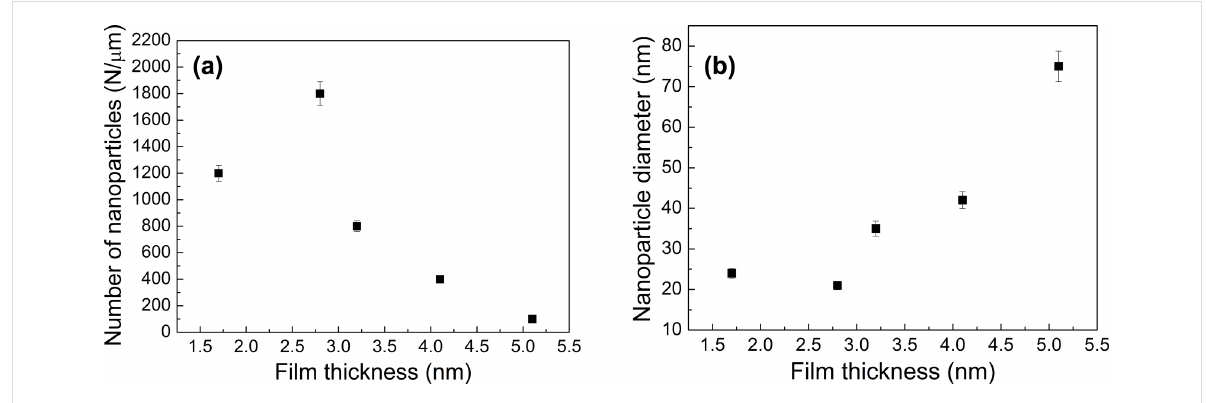
Figure 5: a) Number of nanoparticles and b) average diameter of nanoparticles as function of the Au film thickness on Si(111) substrates annealed at 550 °C for 15 min. Errors are below 5%.